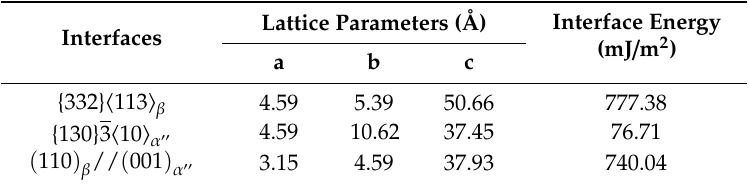
Figure 1. ( a , b ) The 1 × 2 × 1 initial configuration of { 332 }(cid:104) 113 (cid:105) β twin boundary (TB) projected on plane. Yellow and black spheres represent the atoms at the adjacent denotes grain boundary plane, d is the interplanar spacing of ( 332 ) plane in bulk. ‘1’ and ‘ − 1’ denote the atomic planes. ( c ) The energy of the bi-crystal model as a function of d A and δ . Table 1. The lattice parameters of various interface models used in this work and the corresponding interface